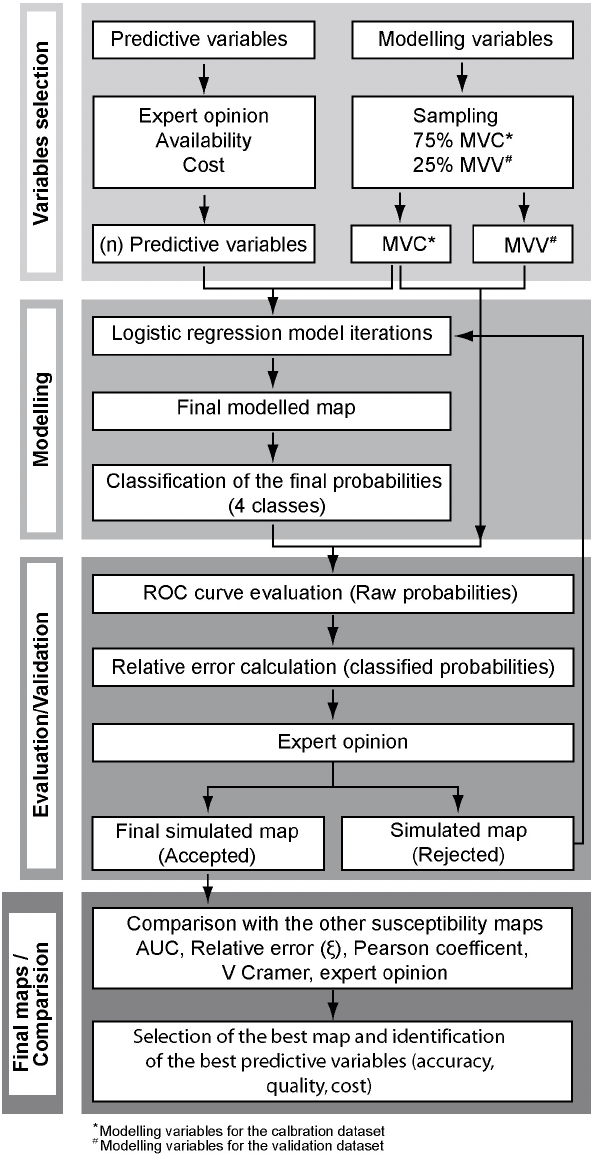
Fig. 8. General flow chart of the employed